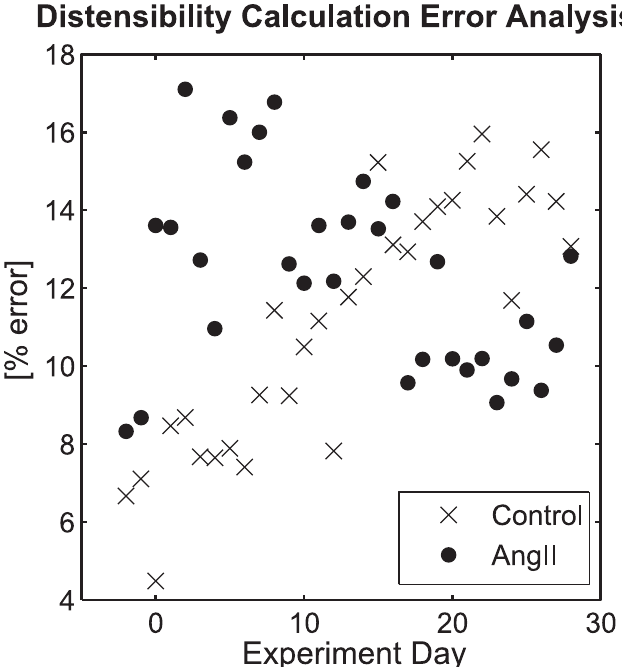
Fig 6. Error Analysis of Pulse Pressure Estimation for Distensibility Calculations by Group. Mean group errors for the calculation of aortic distensibility introduced by the group-averaged estimation of arterial pulse pressure as a function of the time (days) with continuous infusion of AngII (after removal of statistical outlier) or saline ( ‘ Control ’ ).